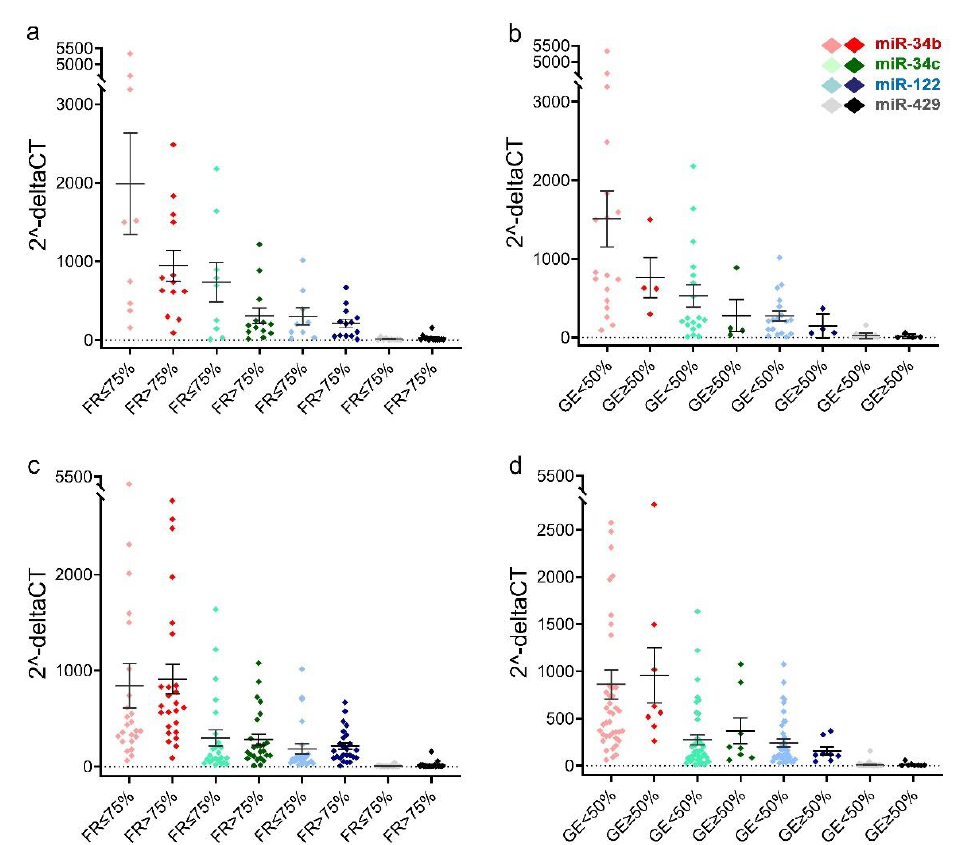
Figure 3. Relative levels of sperm miRNAs in different groups of egg fertilization rates and early embryonic development. Differences in relative levels of miRNAs: ( a ) asthenozoospermia sperm samples between egg fertilization rates >75% and ≤ 75%, ( b ) asthenozoospermia sperm samples between good-quality embryo rates ≥ 50% and <50%, ( c ) teratozoospermia sperm samples between egg fertilization rates >75% and ≤ 75%, and ( d ) teratozoospermia sperm samples between good-quality embryo rates ≥50% and <50%. The data are shown as mean and SEM. FR: fertilization rate; GE: good - quality embryo.